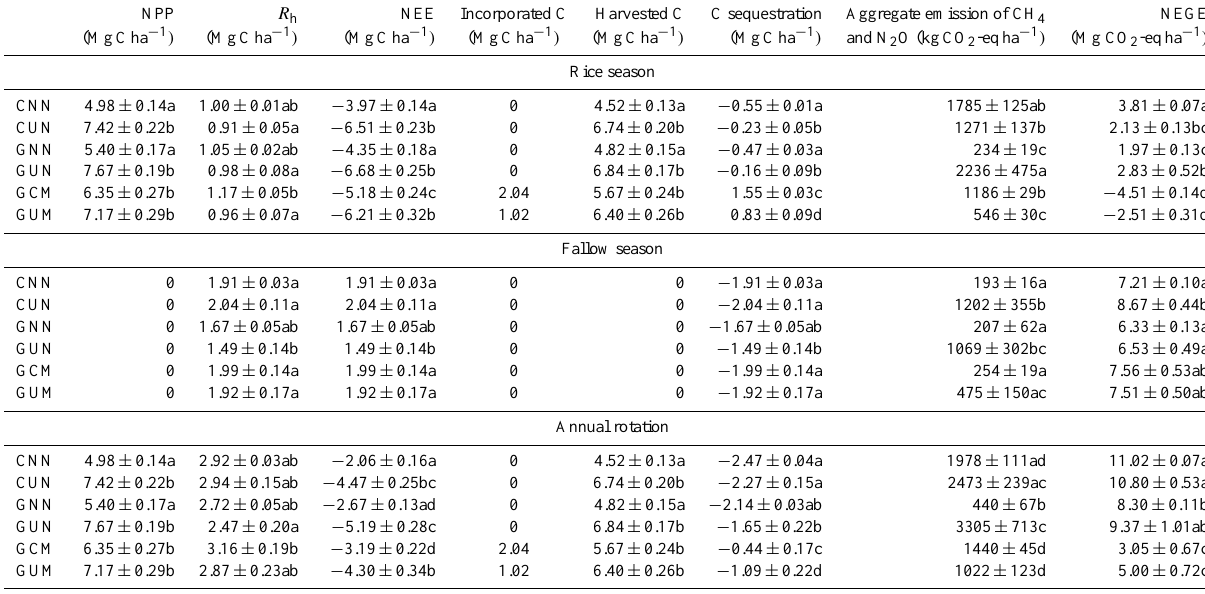
Data shown are means ± standard errors of three spatial replicates. Definitions of abbreviations for the different fertilizer treatments are shown in the footnotes of Table 1 and in the text. Different letters within the same column indicate statistically significant differences among treatments during the periods of rice and fallow seasons as well as annual